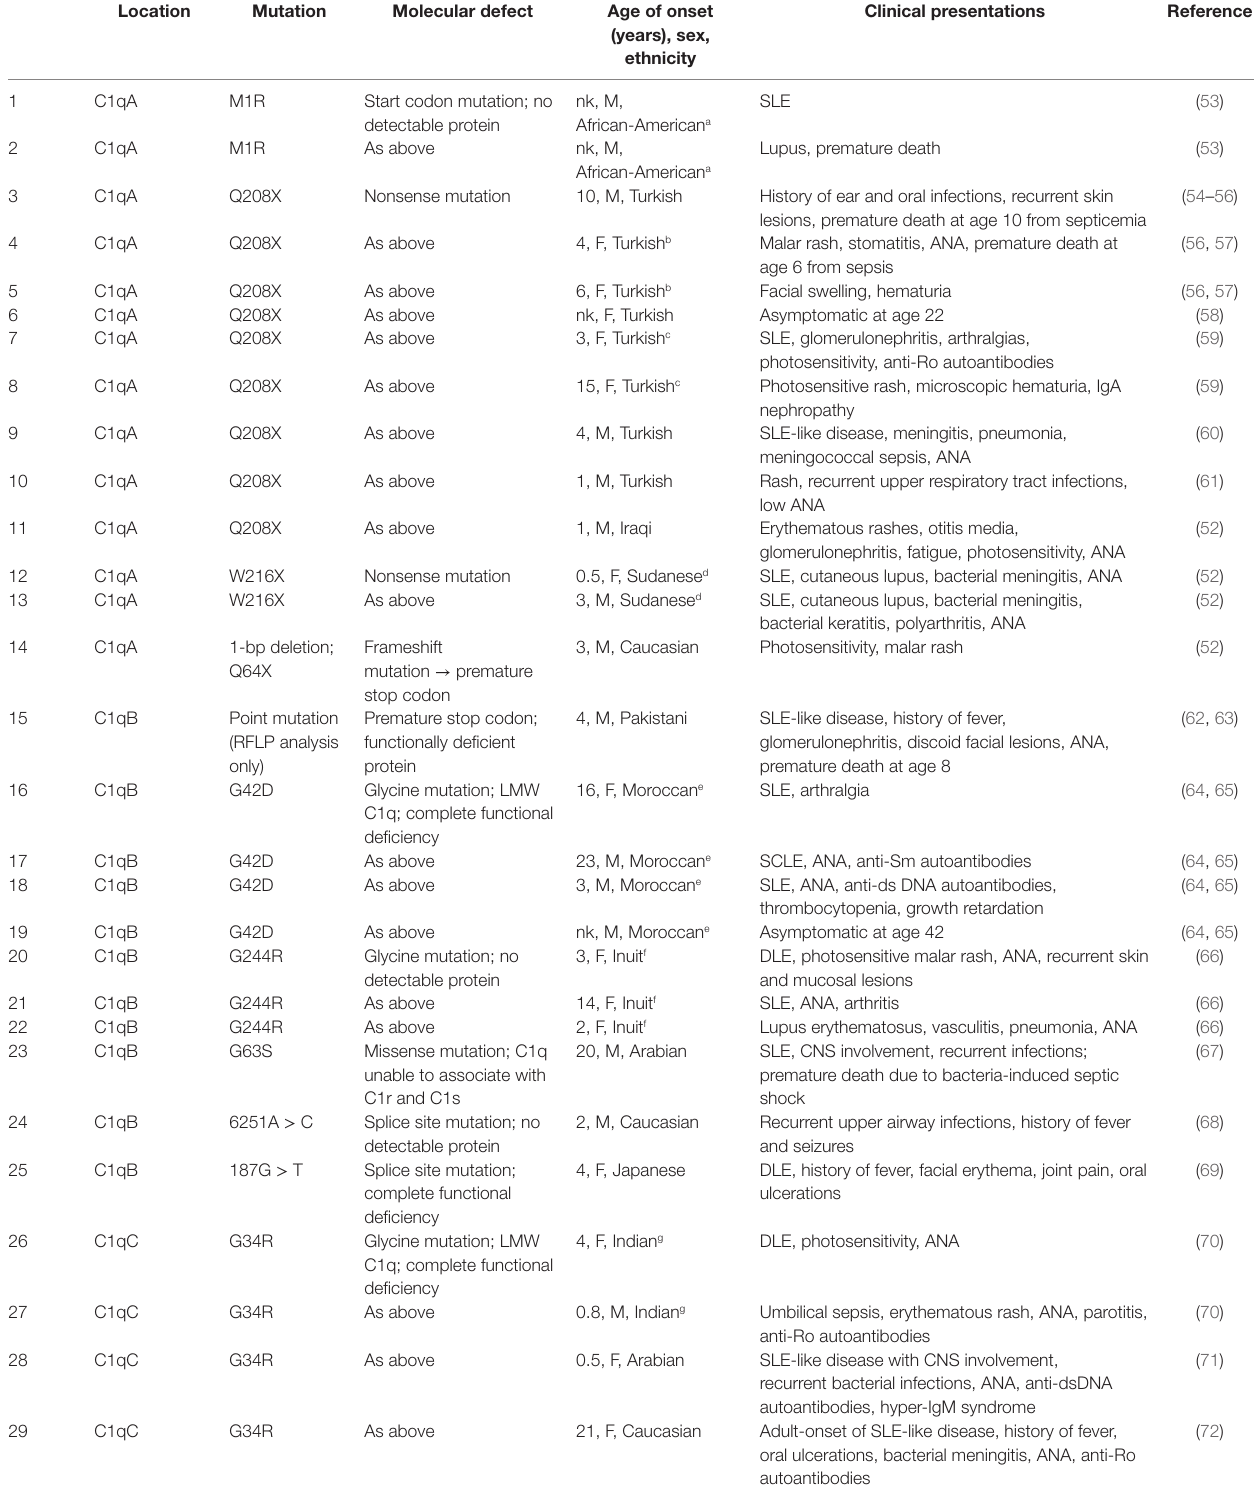
TABLe 1 | Complete deficiency of A, B, or C chain genes of C1q.